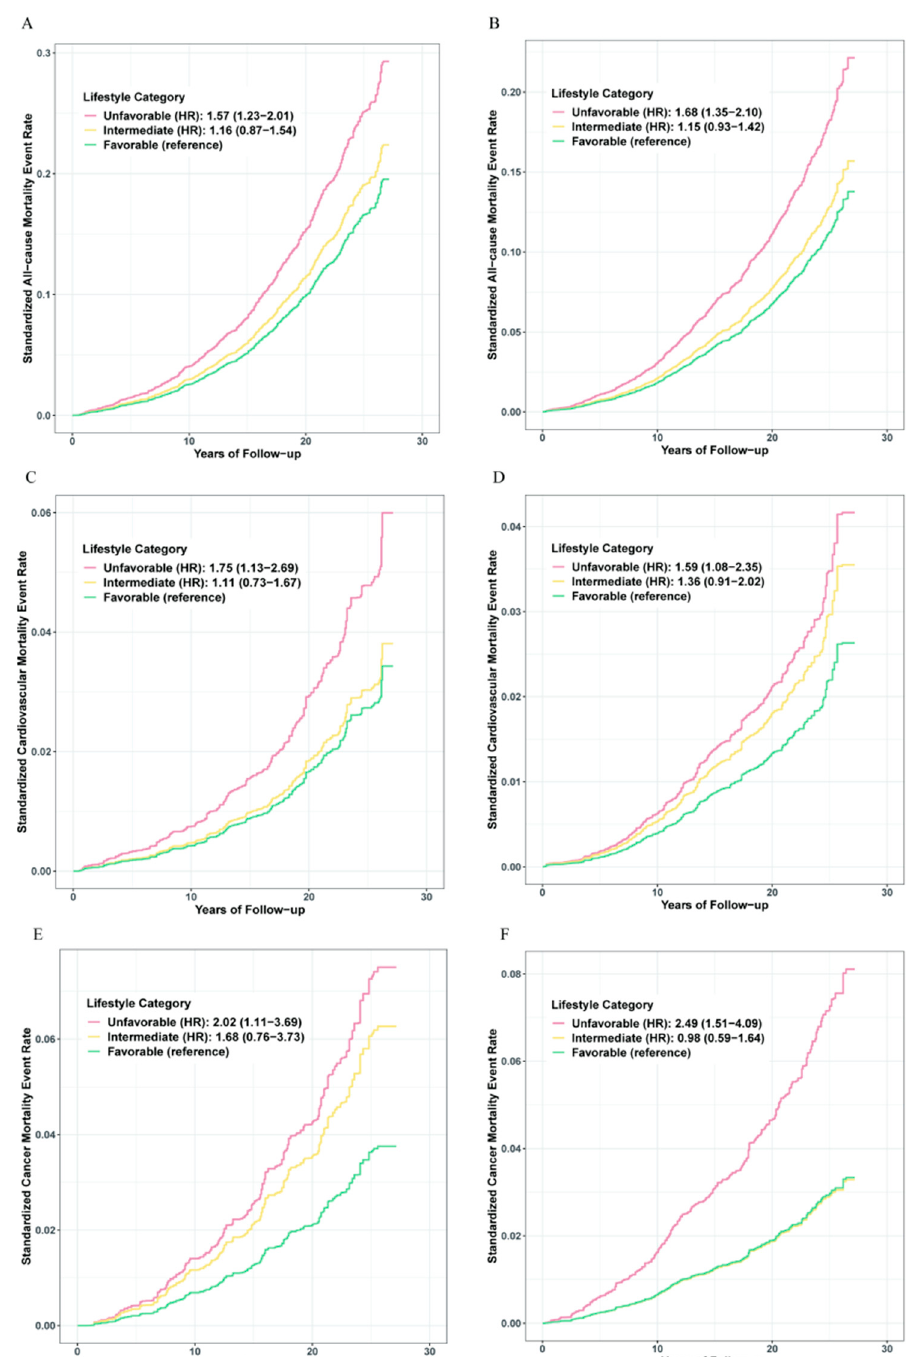
Figure 1. The risk of mortality across lifestyle categories. Standardized rates of mortality events were calculated by using Kaplan-Meier method. HRs and 95% CIs were derived from the Cox regression model. Adjusted for age, sex, ethnicity, poverty status, education level, body mass index, and prevalent comorbidities (including history of hypertension, diabetes, CVD, cancer, chronic bronchitis or emphysema). ( A , C , E ) for participants with NAFLD; ( B , D , F ) for participants without